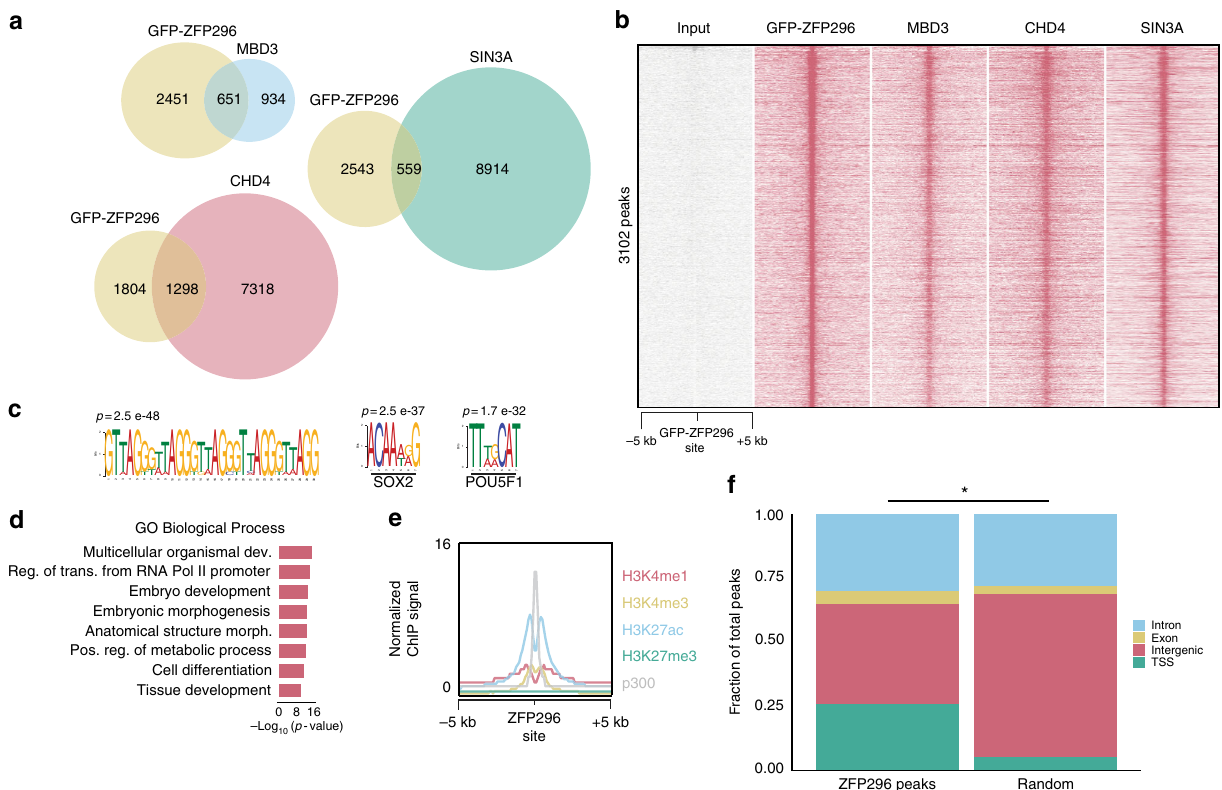
Fig. 3 ZFP296 co-localizes with NuRD and SIN3A in ESCs. a Venn diagrams summarizing the overlap between GFP-ZFP296 peaks and NuRD or SIN3A ChIP-seq results in ESCs. b Heat map showing the ChIP-seq read density for input, GFP-ZFP296, MBD3, CHD4, and SIN3A, centred on GFP-ZFP296 ChIP- seq peaks. c Top three most signi fi cant motifs enriched under GFP-ZFP296 ChIP-seq peaks. d GO term enrichment analysis of Biological Processes for genes within 100 kb of a GFP-ZFP296 peak (nearest gene only). e Band plot of four different histone marks and p300 (publicly available data 19 ) at GFP- ZFP296 binding sites. f Genomic distribution of GFP-ZFP296 ChIP-seq peaks in ESC compared to a set of random regions ( n = 3102) of the same average length. TSS peaks were + 5 kb/ − 1 kb from a transcription start site. * p < 0.05, as assessed by Chi-squared (Fig. 3a, b). Strikingly, the most enriched DNA sequence motif under ZFP296 peaks is TTAGGG, which is the telomere repeat motif (Fig. 3c). Additionally, the SOX2 and POU5F1/OCT4 DNA